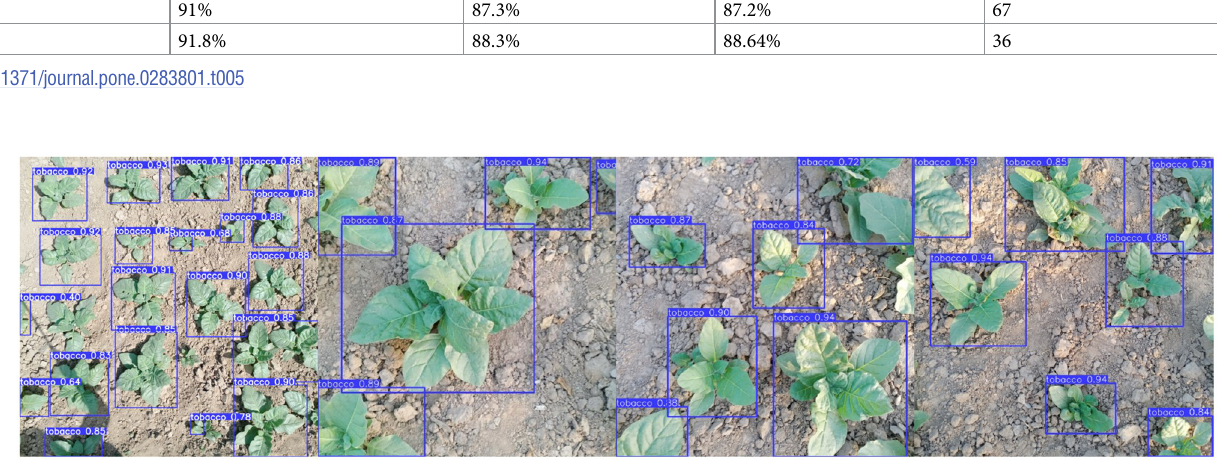
Fig 10. Detection of tobacco plant using YOLOv5n